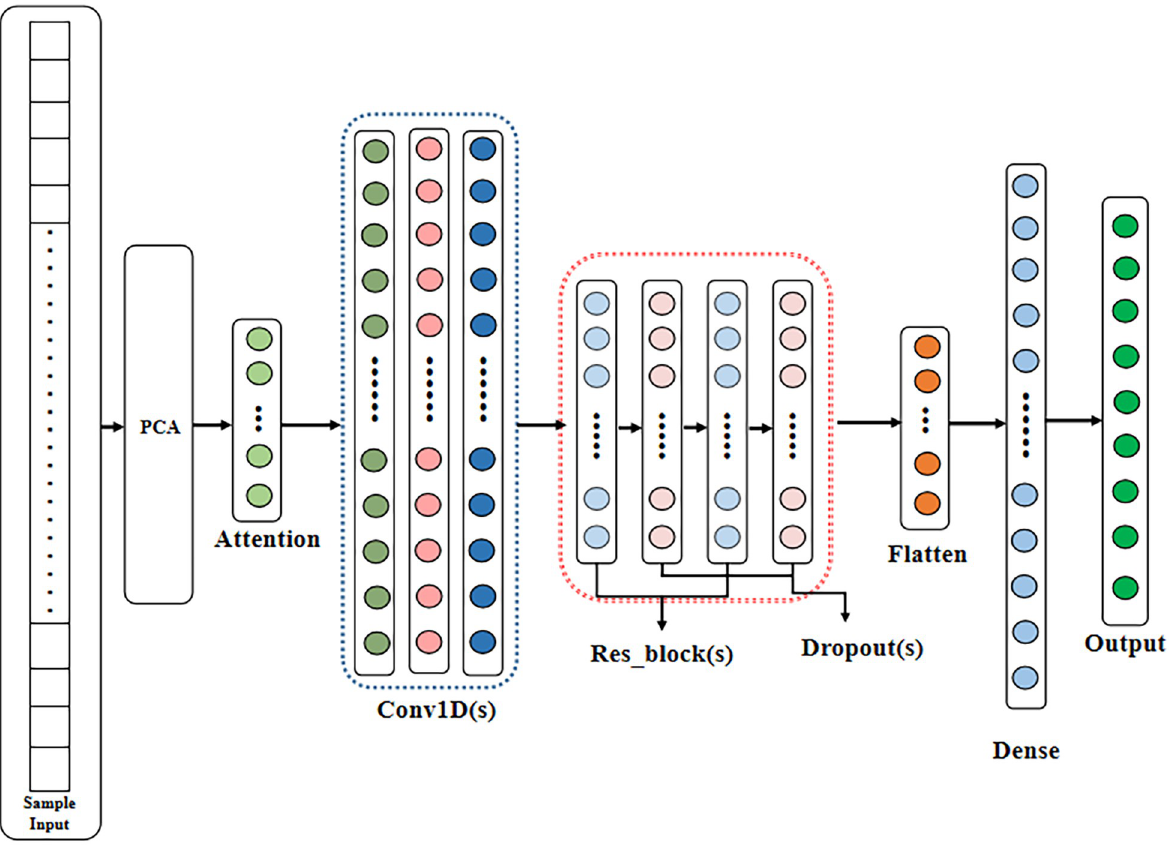
Fig 5. Model structure of